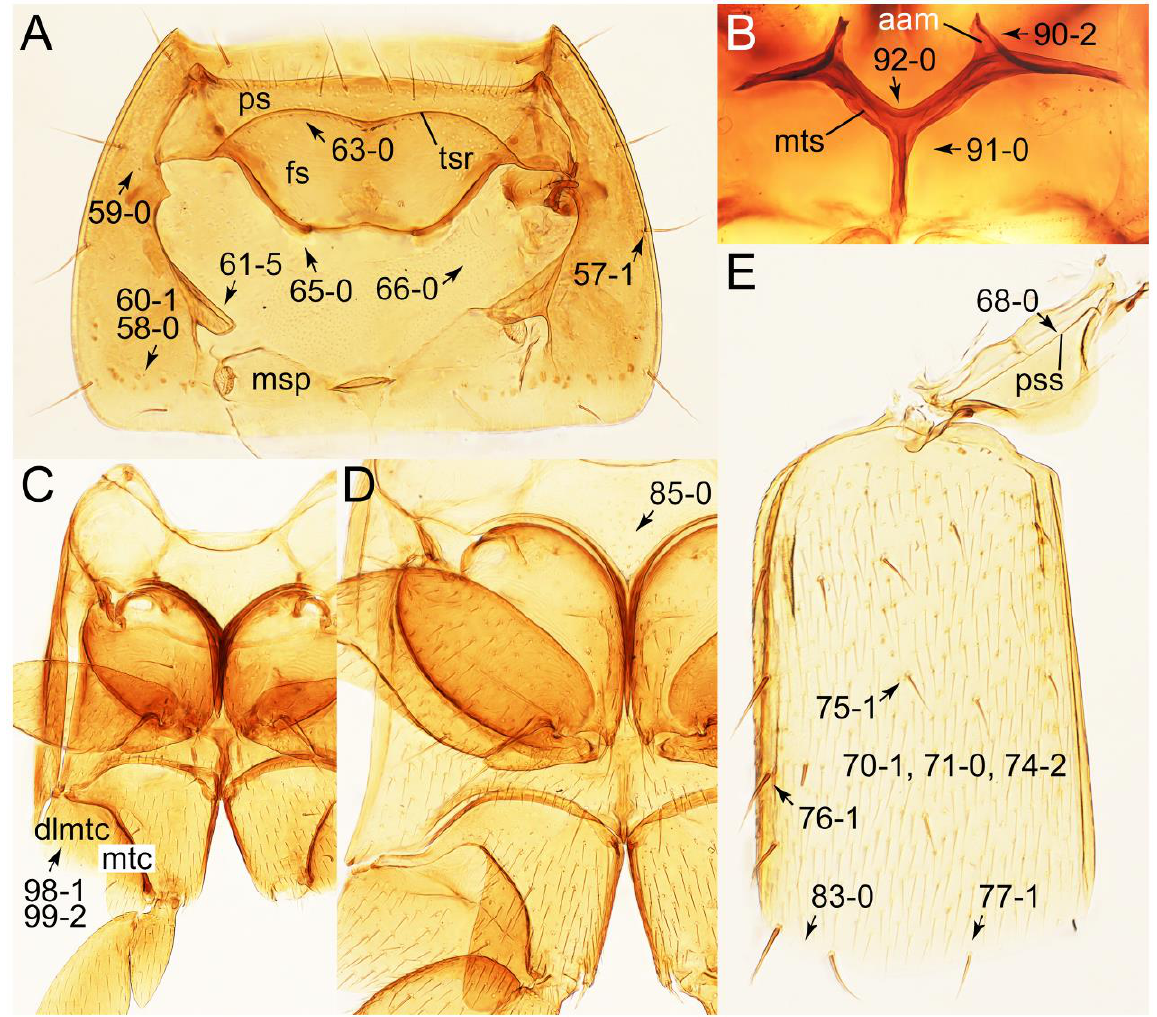
Figure 11. Photographs of body parts of Tachyporini: Tachyporina, enlarged. ( A ) prosternum and pronotum of Palporus nitidulus , ventral view. ( B ) metendosternite of Tachyporus jocosus , dorsal view. ( C ) mesothorax and metatho- rax of Palporus nitidulus , ventral view. ( D ) mesothorax and metathorax of Lamprinus erythropterus , ventral view. ( E ) scutellum and left elytron of Palporus nitidulus , dorsal view. Abbreviations: aam, anterior arm of metendosternite; dlmtc, dorsal lamella of metacoxa; fs, furcasternum; msp, mesospiracular peritremes; mtc, metacoxa; mts, metendosternite; ps, prosternum; pss, prescutoscutellar suture; tsr, transverse sternacoxal ridge of prosternum. Characters and character states (format X-X) are indicated on each